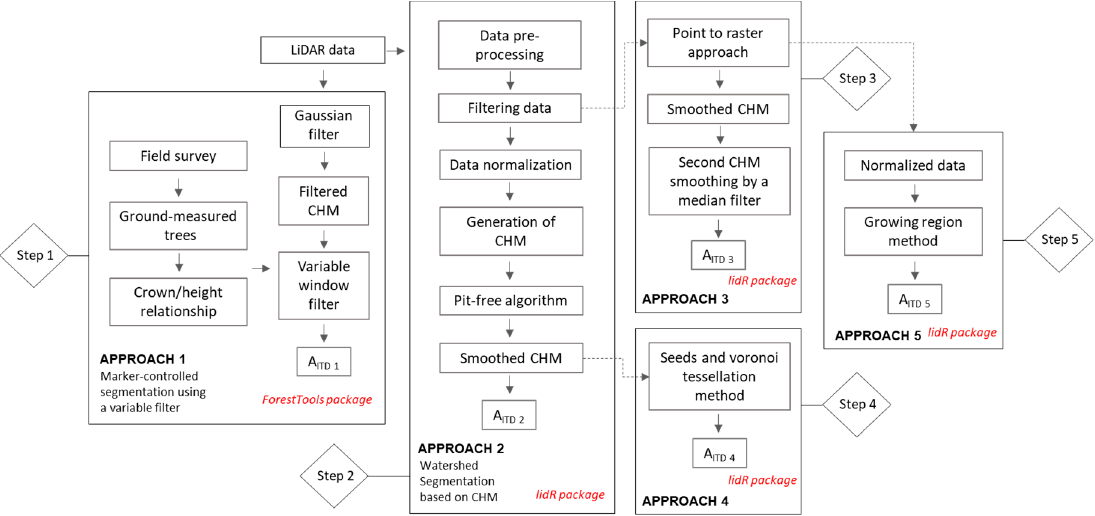
Figure 4. Steps and processes for A ITD (A ITD : automated individual tree detection, CHM: canopy height model).